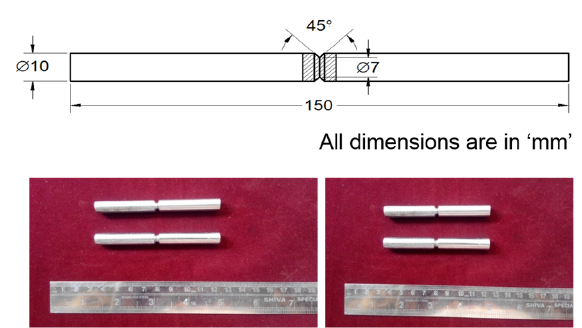
Figure 4: Dimension details and photograph of notch tensile speci-